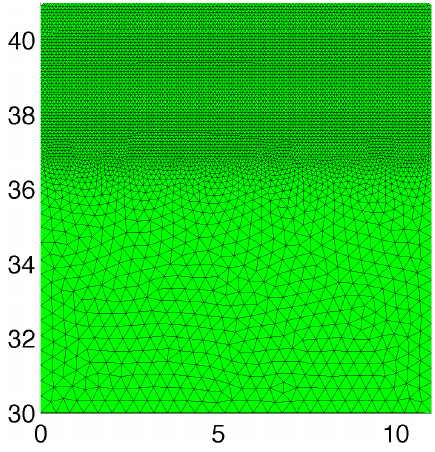
Figure 1. Triangular mesh used in simulations. The resolution varies from approximately 40 to 10km. Stability of EVP and mEVP on the fine mesh requires that α,β and N EVP be sufficiently large.